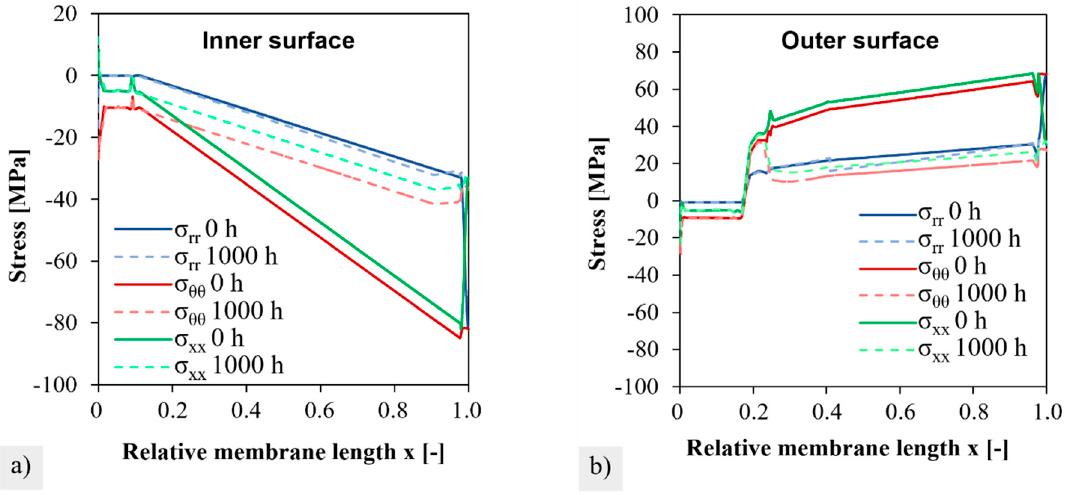
Figure 11. Change in stress components during 1000 h virtual module operation with creep relaxation. σ rr ist the radial, σ θθ the tangential, and σ xx the axial